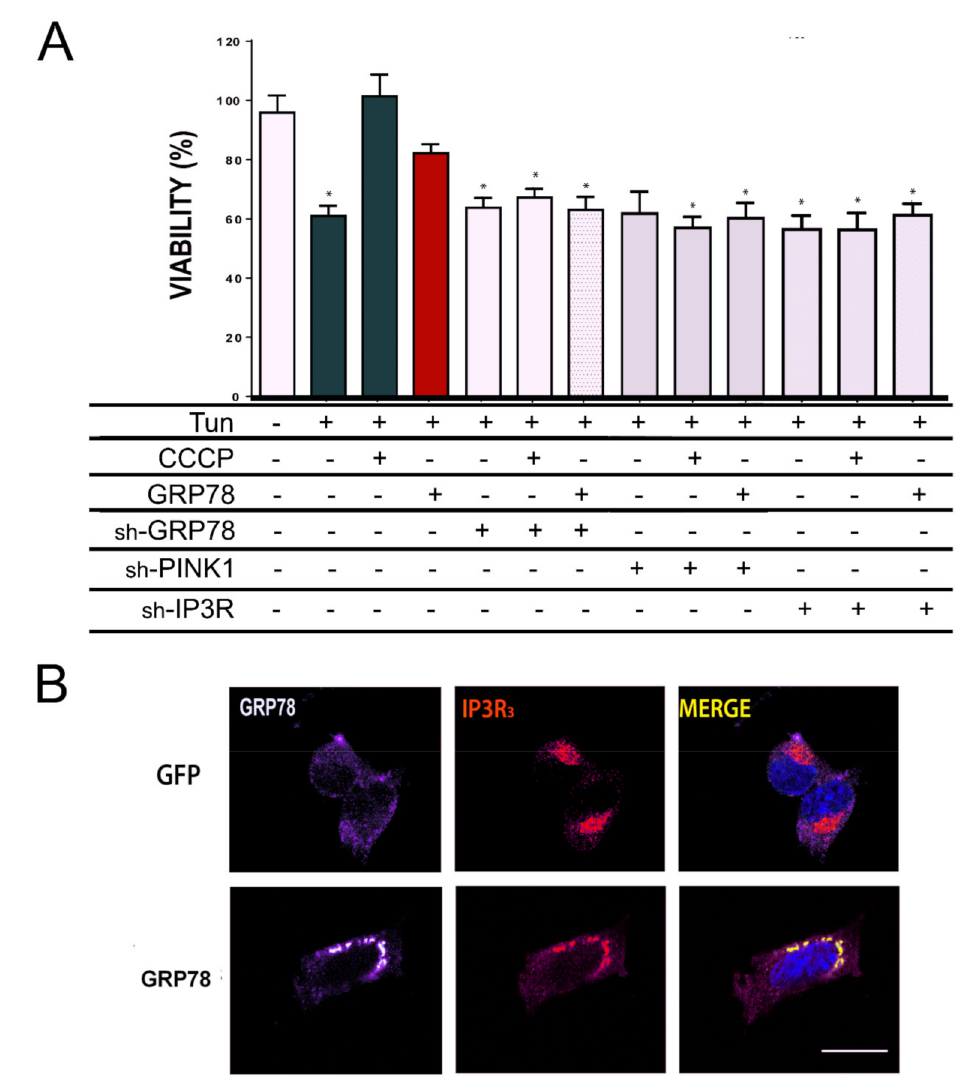
Figure 5. IP3R and PINK1 are necessary for GRP78-mediated neuroprotection. ( A ) The percentage of cell survival (means ± SEM) in NSC34 cells treated with indicated solutions (Tun or CCCP) or submitted to nucleofection of specified plasmids (GFP as a control, GRP78 or shRNA against GRP78, PINK1, IP3R). Cells that did not overexpress GRP78 were GFP positive. Viability was determined by MTT assay after 24 h (GFP-Veh is the control group) ( n = 4–8, * p < 0.05 vs. GFP-expressing vehicle-treated cells). ( B ) Representative confocal images of GRP78 (red) and IP3R (green) in cells that overexpress GFP or GRP78. Scale bar = 10 µ